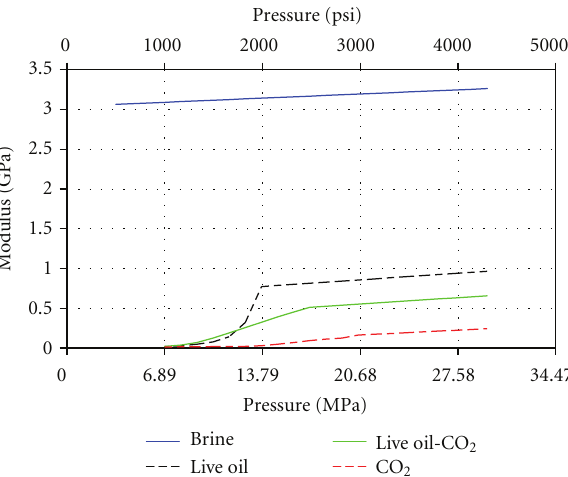
Figure 5: Bulk modulus of fluids as a function of pressure, modeled using the FLAG calculator